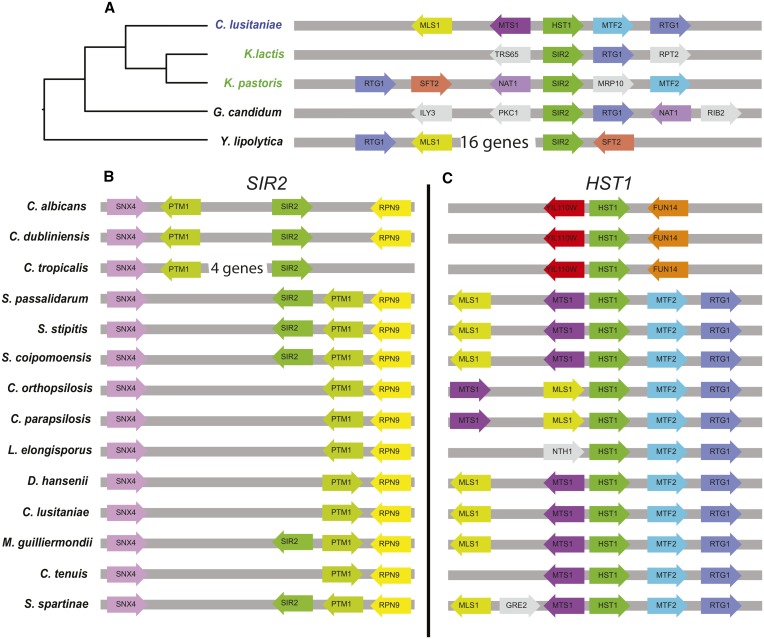
HST1 is at the original locus of the SIR2/HST1 gene. Gene order was determined using the Candida gene order browser (Maguire et al. 2013) and the comparative genomics CoGe browser (Lyons and Freeling 2008). Orthologous genes are indicated by a consistent color, and the orientation of the coding strand is indicated by the arrow. (A) Gene order surrounding HST1/SIR2 is shown for representative species across the Saccharomycotina. (B) Gene order surrounding SIR2 is shown for all CTG species examined. (C) Gene order surrounding HST1 is shown for all CTG species examined.